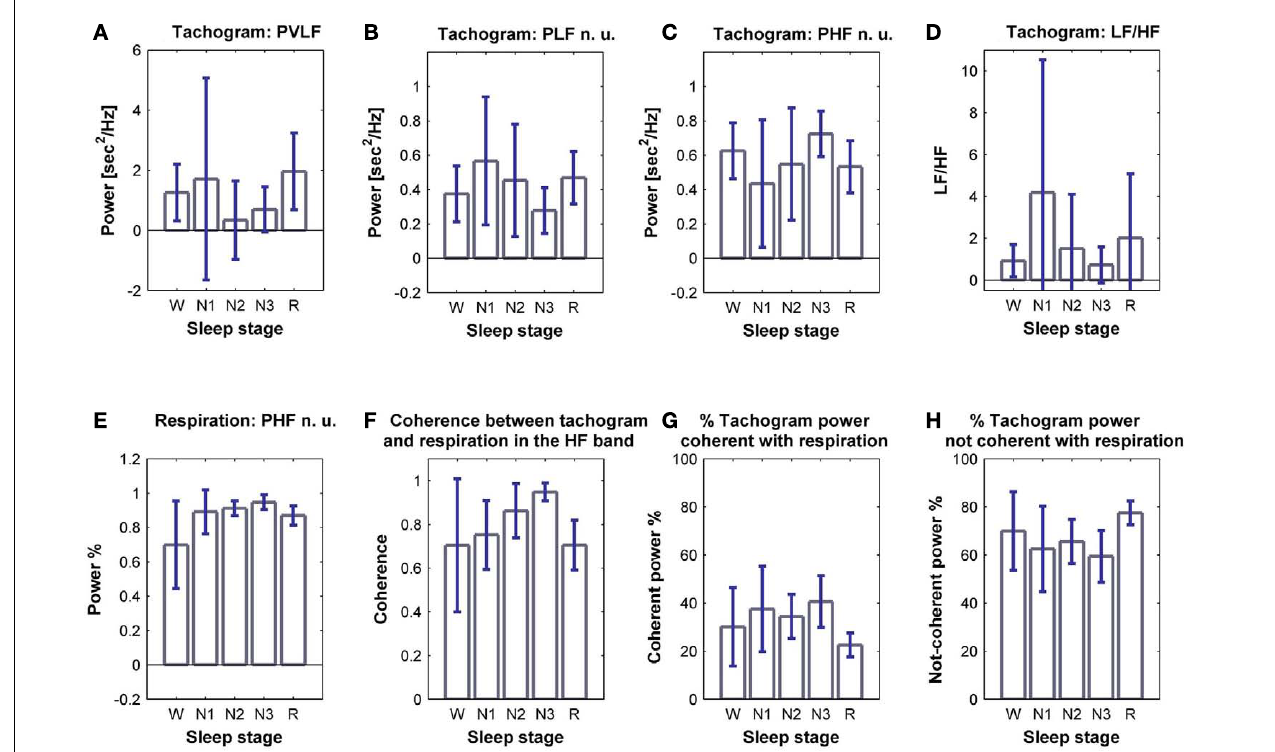
night; (F) coherence between the tachogram and the respirogram in the HF band, tachogram power % (G) coherent and (H) not-coherent with the respirogram, calculated on all subjects for wakefulness and the different sleep stages, for the whole night. SD values are indicated in